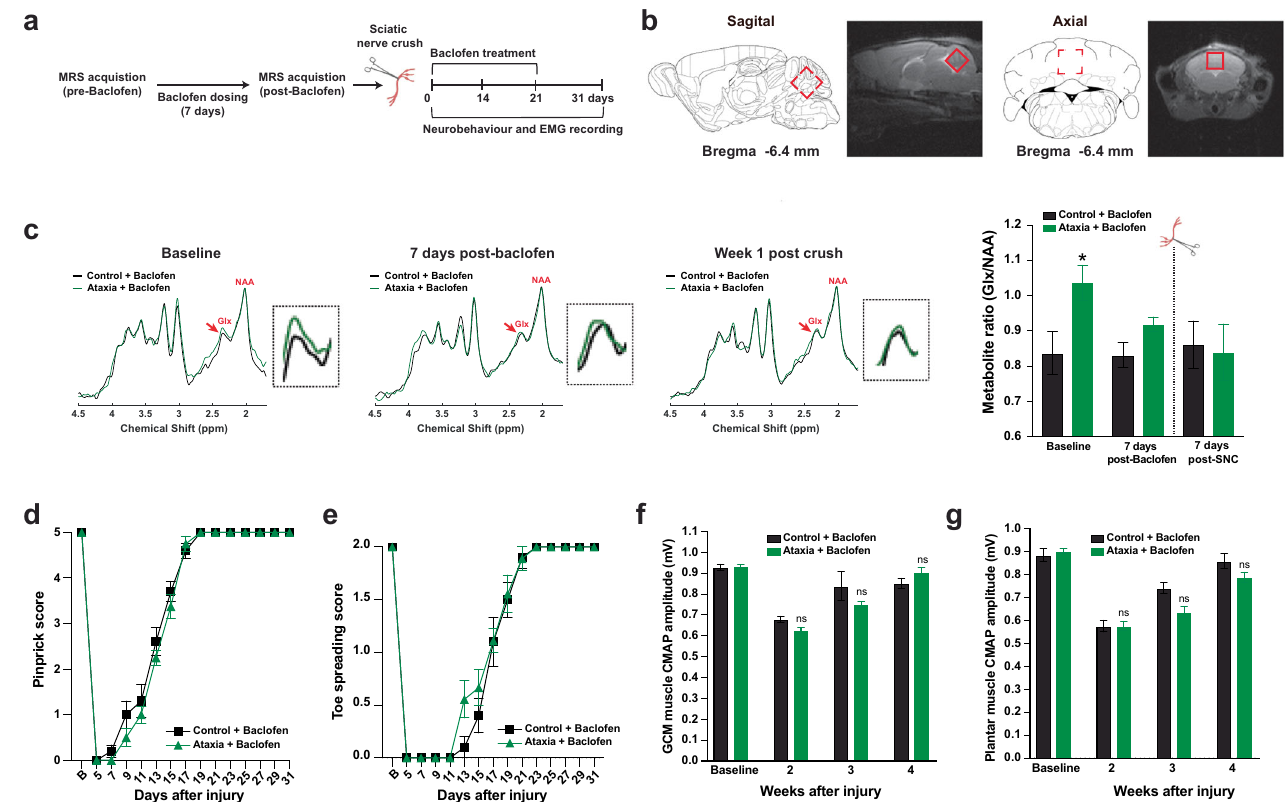
Fig. 5 Baclofen reverses neurotransmitter imbalance as detected by magnetic resonance spectroscopy (MRS) and recovers spontaneous motor function after injury. a Schematic diagram illustrating the experimental paradigm for baclofen treatment and MRS acquisition. b Sagittal and axial T 2 weighted images with the voxel of interest placed within the cerebellum (red squares). MRS data were analyzed by a customized MATLAB program. Schematic illustrations of sagittal and coronal sections were adopted from the Allen Mouse Brain Atlas (Reference Atlas Version 1, 2008). c Representative MRS spectra of control and ataxia mice were shown at different timepoints. MRS spectra were aligned by setting N-acetylaspartate (NAA) peak at 2.2 parts per million (ppm) and glutamate-glutamine (Glx) at 2.34 ppm as shown by red arrows. Glx level in ataxia mice was signi fi cantly higher than in control mice and restored to baseline levels of control mice after one week of baclofen treatment. d – g Ataxia mice treated with baclofen showed a similar level of restoration of sensory and motor function, and EMG activities, compared to control mice after SNC. n = 5 per group for MRS experiments ( b and c ). n = 9 – 10 mice per group for neurobehavioral experiments and EMG recording ( d – g ). Values represent the mean ± SEM; two-way ANOVA followed by post hoc Bonferroni test except in L, unpaired Student ’ s t -tests were used; * P < 0.05; ** P < 0.01, *** P < 0.001. ns non-signi fi cant. Detailed statistics analyses comparing compound muscle action potential (CMAP) amplitude data points across time within groups are available in Supplementary Table